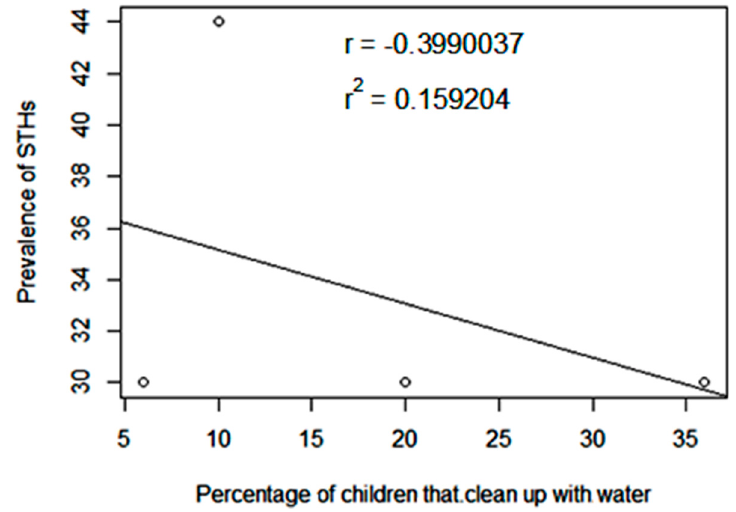
Figure 4. Association between prevalence of soil-transmitted helminths (STHs) and proportion of children that clean up with water.